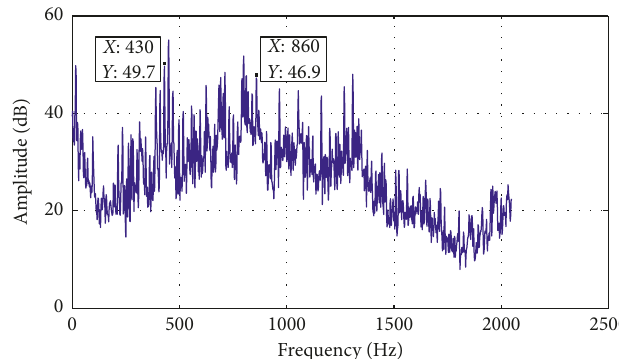
Figure 6: Spectrum analysis of reference source 3 under fault